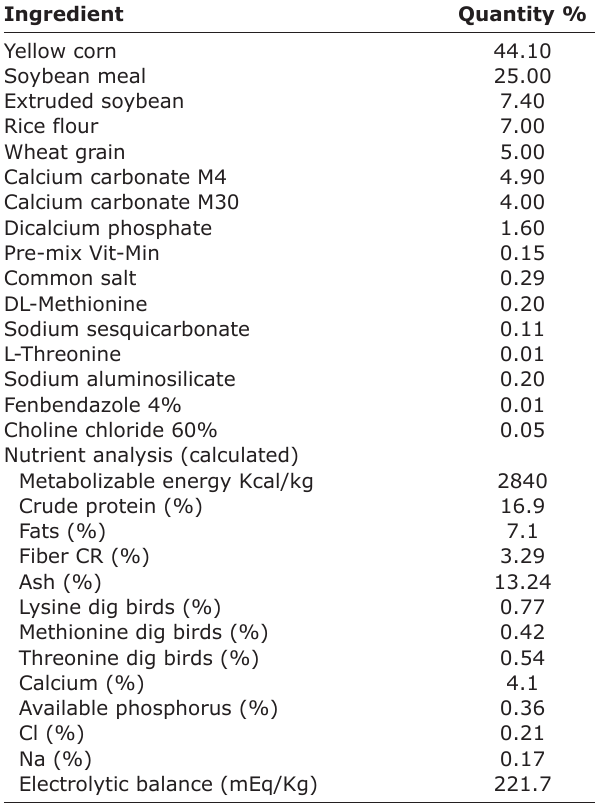
Table-1: Nutritional composition of the basal diet formulated for the treatments.